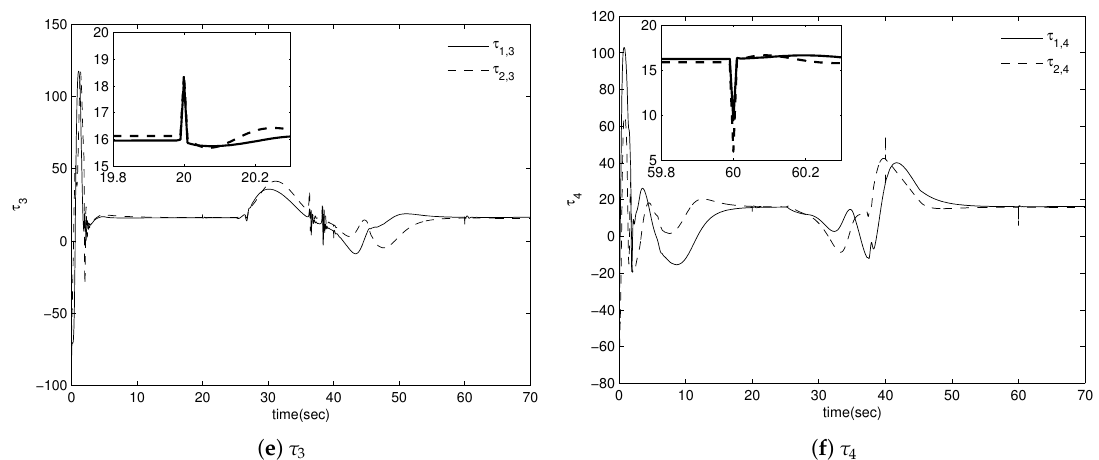
Figure 8. Simulation results for impulse attack